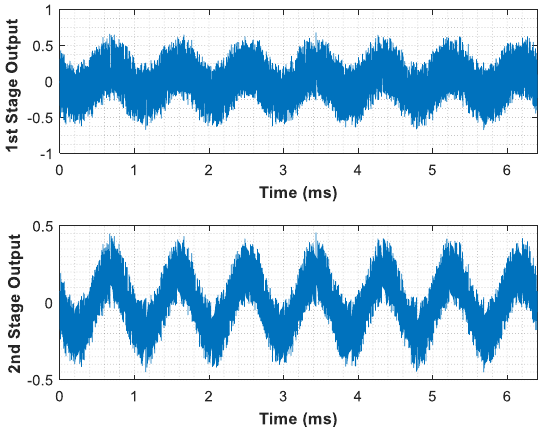
Figure 18. The ΔΣ modulator’s two integrator outputs. Figure 18. The ∆Σ modulator’s two integrator